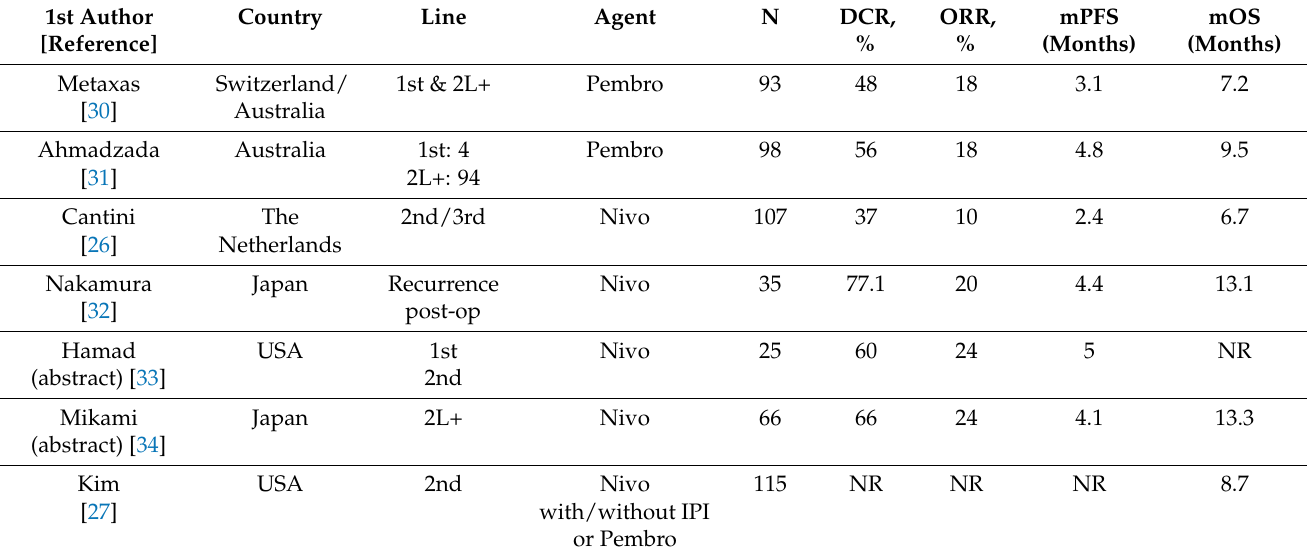
Table 3. Summary of real-life studies evaluating ICI monotherapy for metastatic pleural